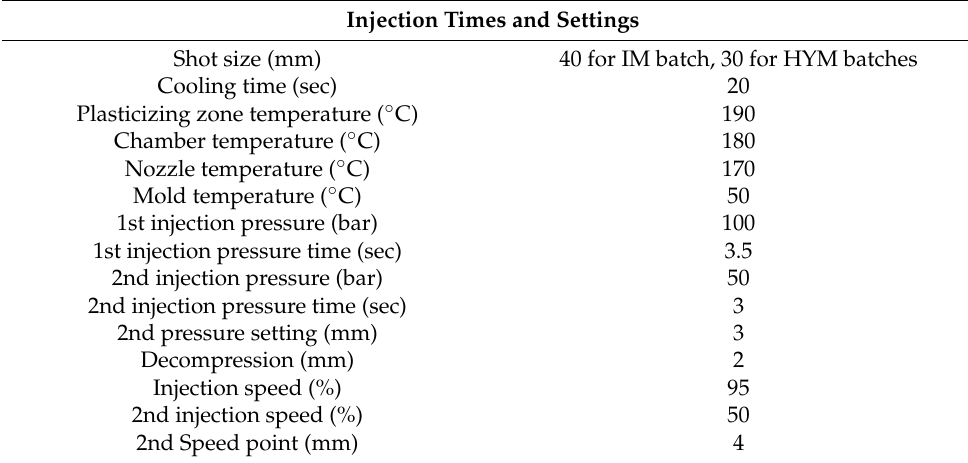
Table 2. Parameters of IM applied in the study.